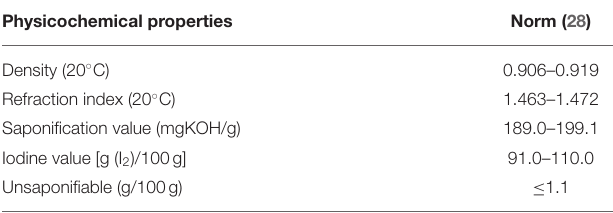
TABLE 2 | The fatty acids, phytosterols, and tocopherols composition of argan oil. Fatty acid